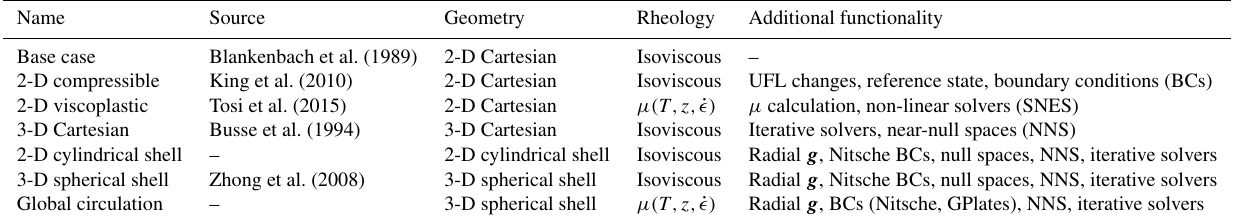
Table 1. Summary of cases examined here, which systematically increase in complexity. The key differences and challenges differentiating each case from the base case are highlighted in the final